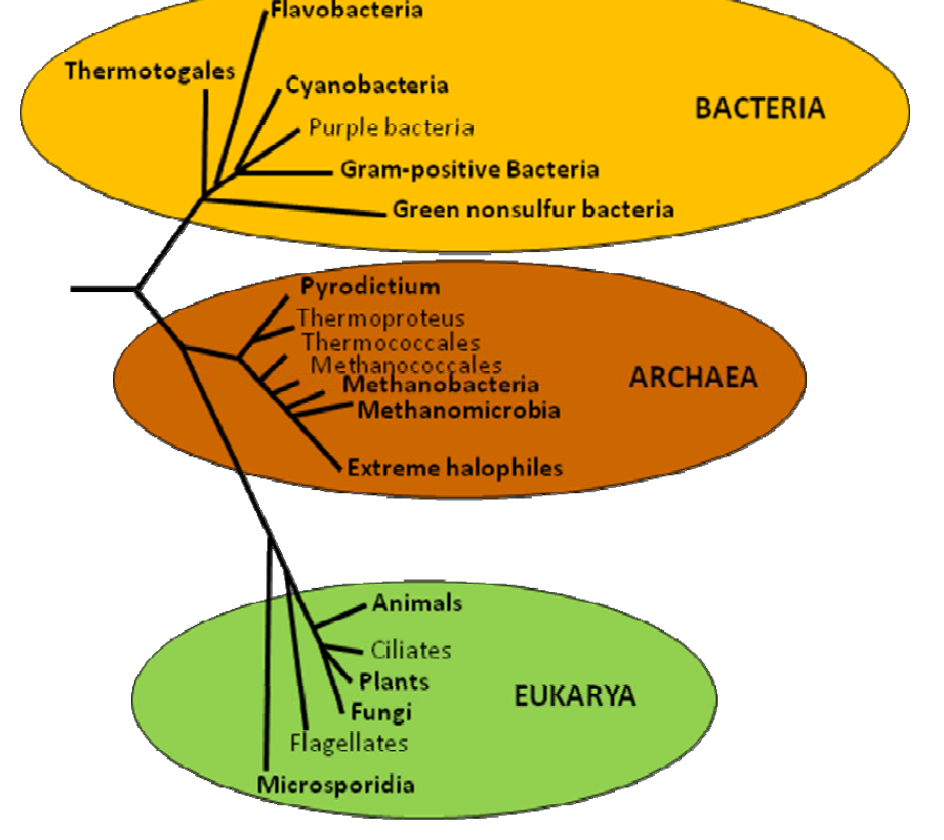
Figure 1. Evolutionary history of trehalose biosynthesis. The trehalose biosynthetic pathways are present in the three domains of life tree. Phyla in bold letters show organisms that have at least one of the five routes of trehalose